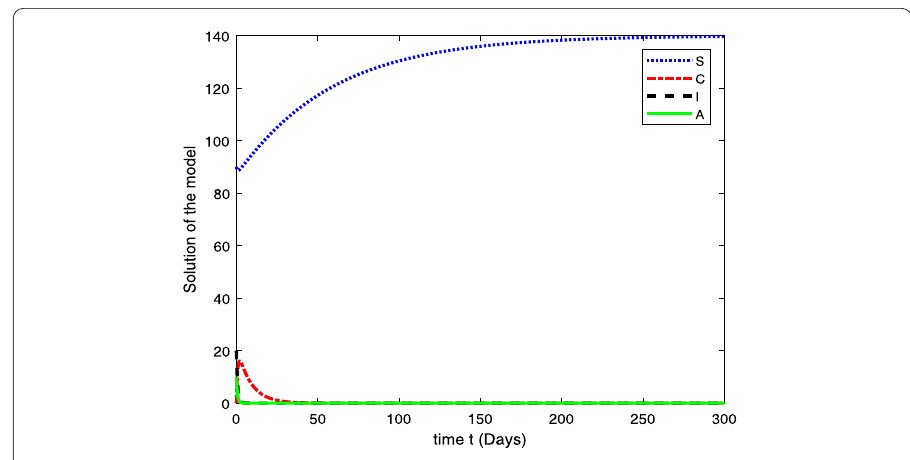
Figure 5 The solution for (1) for S , I , C , A , keeping h = 0.1 and α = 1